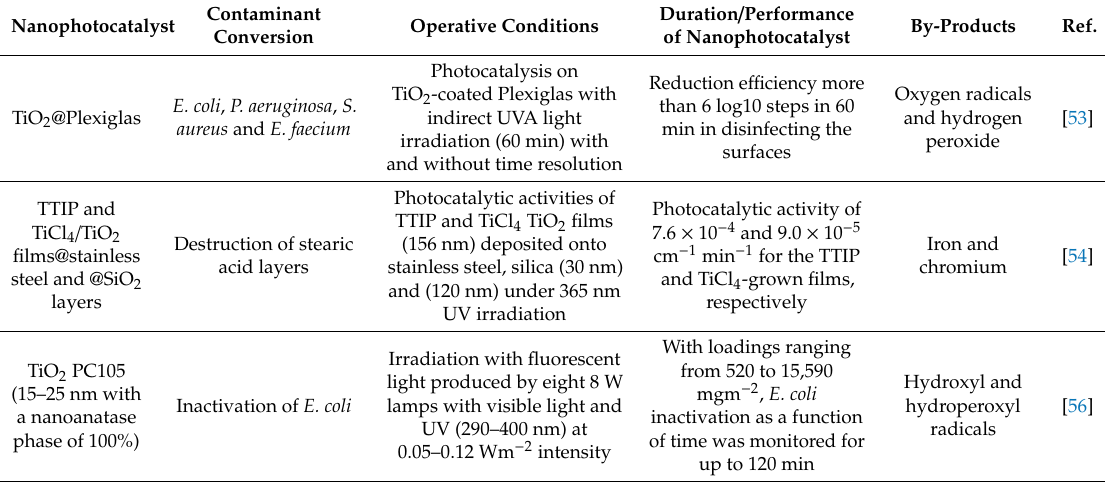
Table 1. Summary of the main findings of nanophotocatalytic